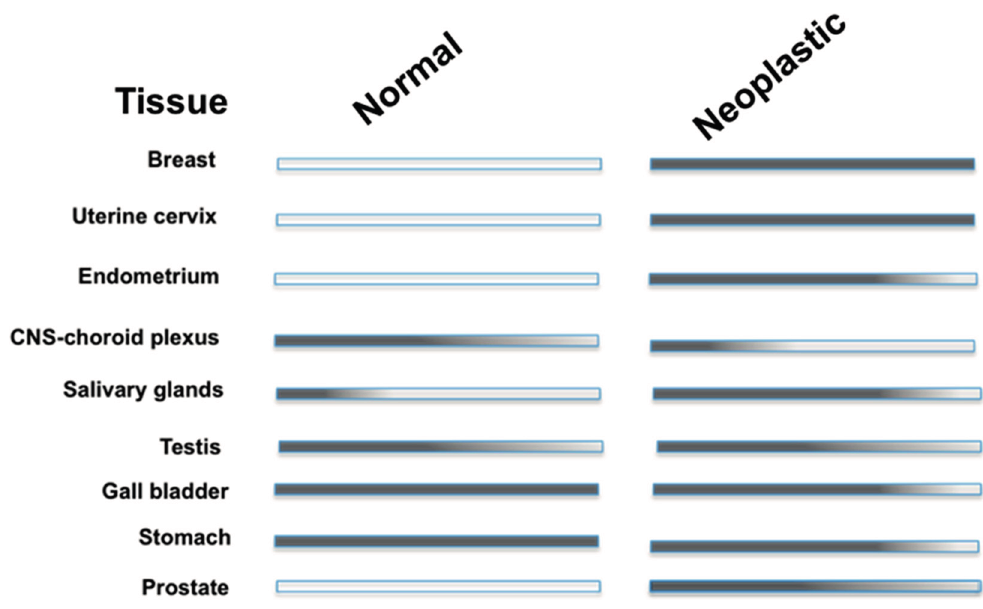
Figure 2. CA IX expression in adult human tissue. Note that (*) indicates high-grade tumor